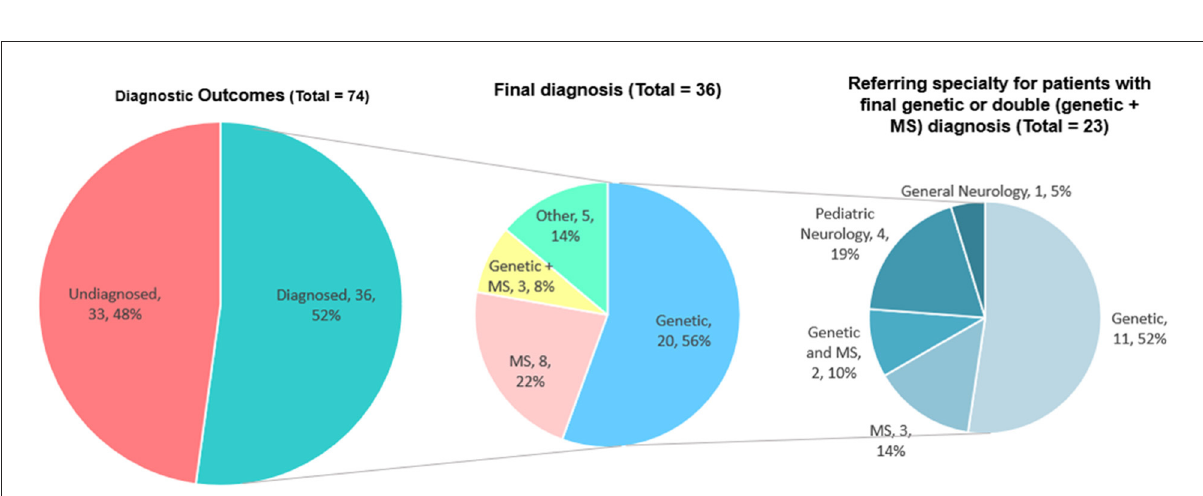
FIGURE4 Definite diagnoses in the cohort of 74 subjects presented at the WM Rounds. The data of patients with definite genetic diagnoses are presented according to the subspecialty of their referral physician